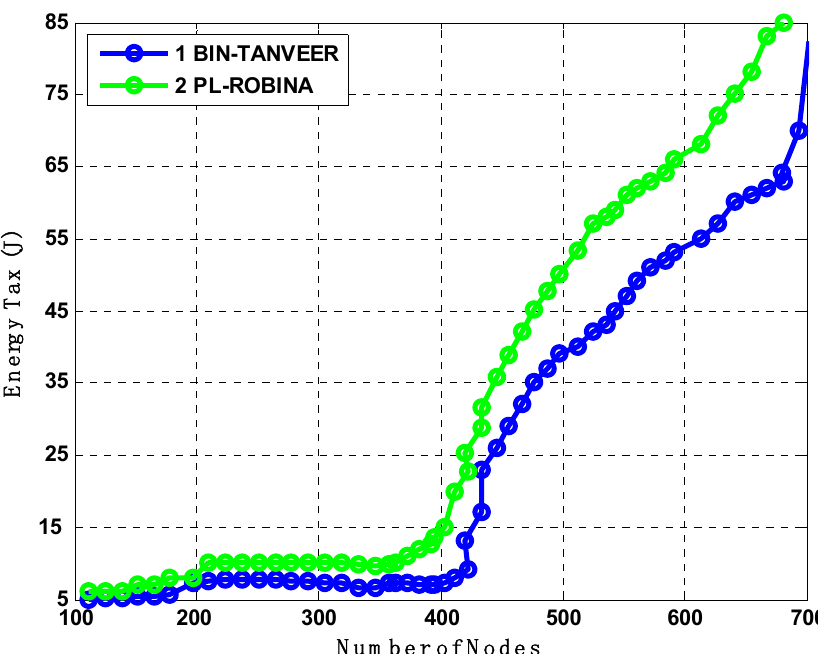
Figure 18. Analysis of energy tax compared with BIN-TANVEER and PL-ROBINA.